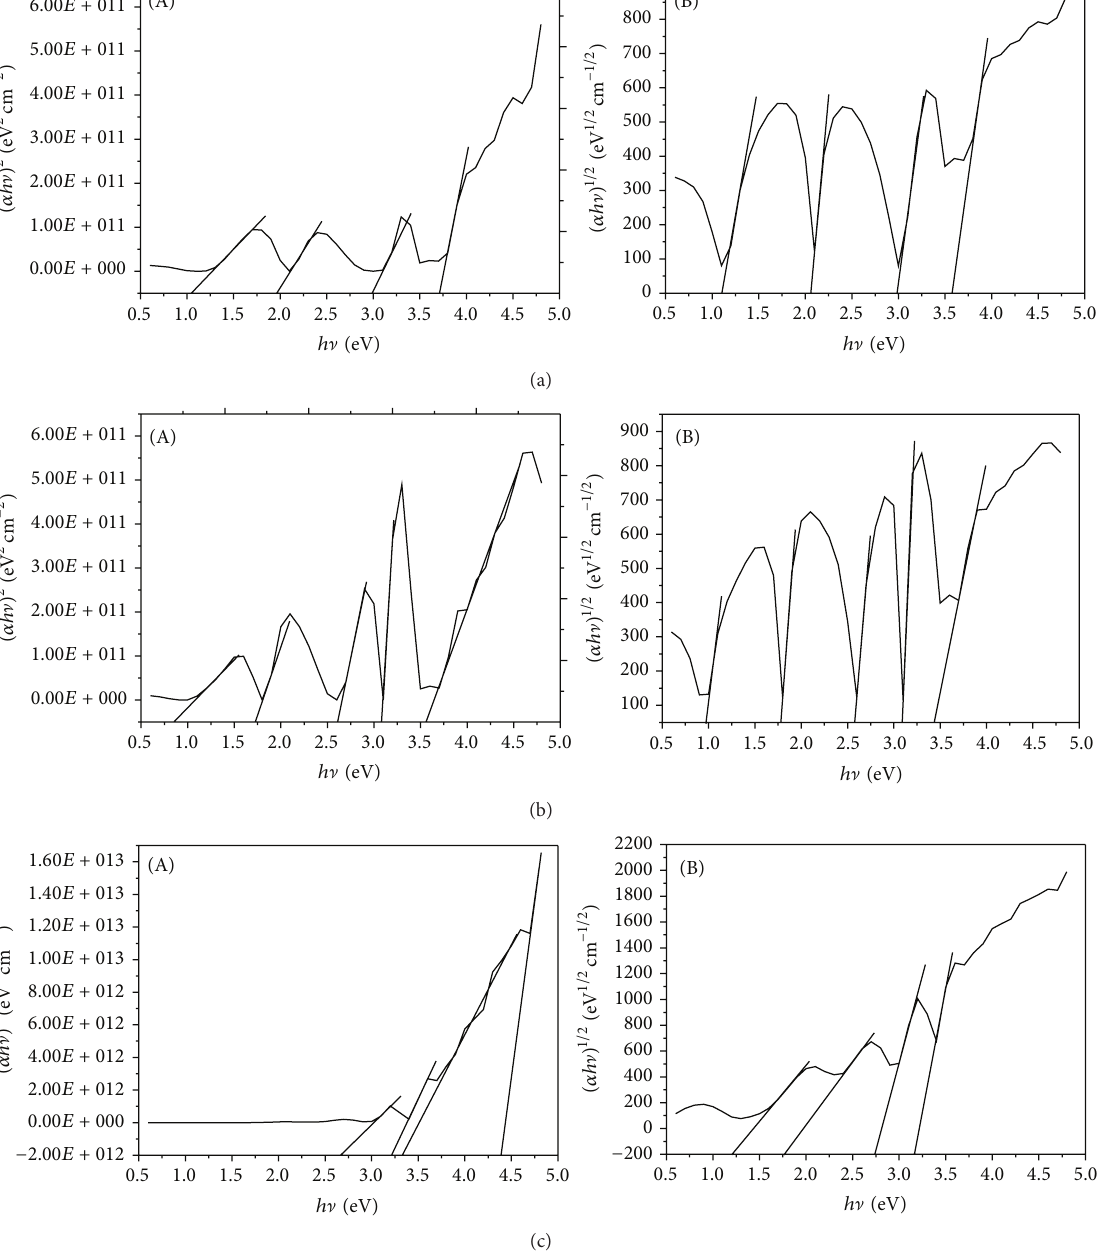
Figure 7: Dependence (𝛼ℎ ] ) 2/𝑎 as a function of radiation energy ℎ ] for (a) sample 1, (b) sample 2, and (c) sample 3 ((A) direct transition ( 𝑎 = 2 ) and (B) indirect transition ( 𝑎 = 4